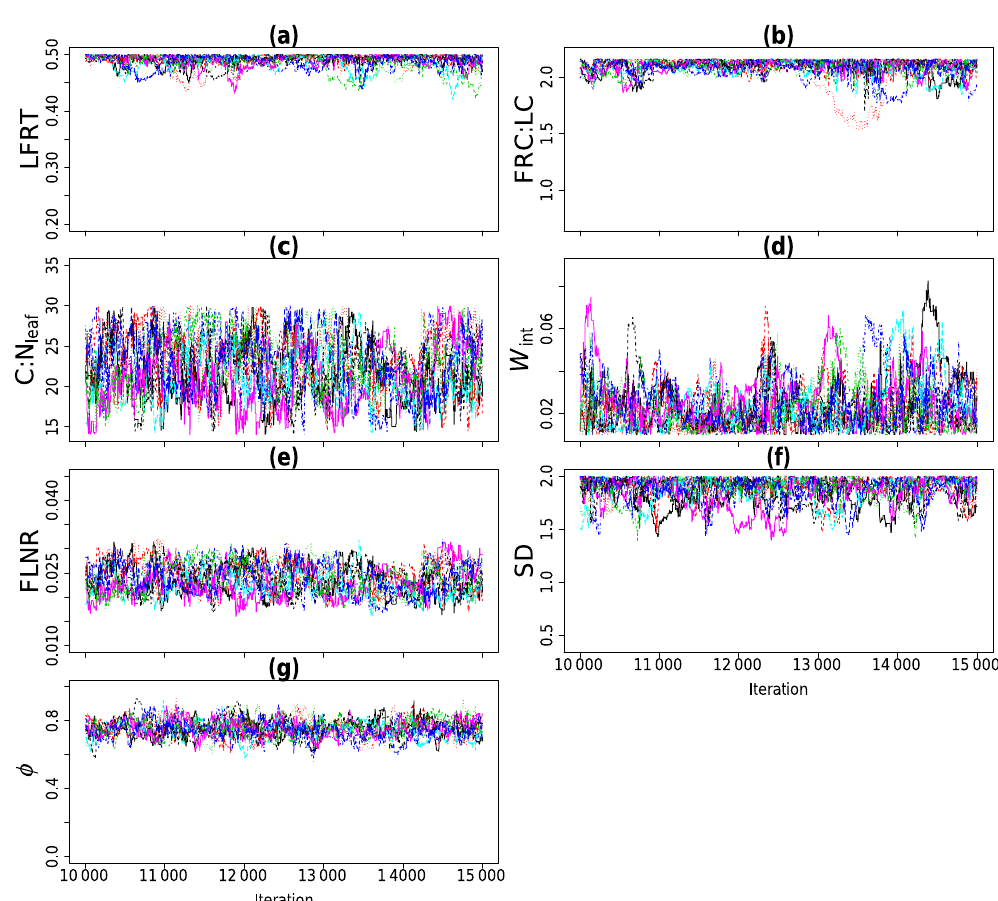
Figure 1. Trace plot of each calibrated Biome-BGC parameter and φ (nuisance parameter of likelihood function of Eq. 5) for Experiment 1 after the burn-in period of 10000. Information about the Biome-BGC parameters is given in Table 1. SD is the effective soil rooting